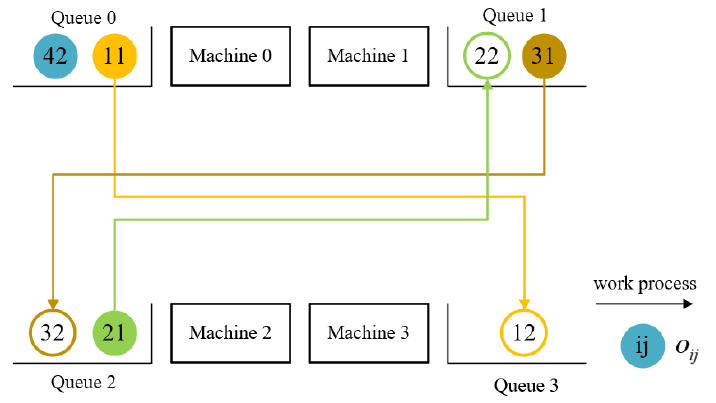
Figure 2. Job processing flow.